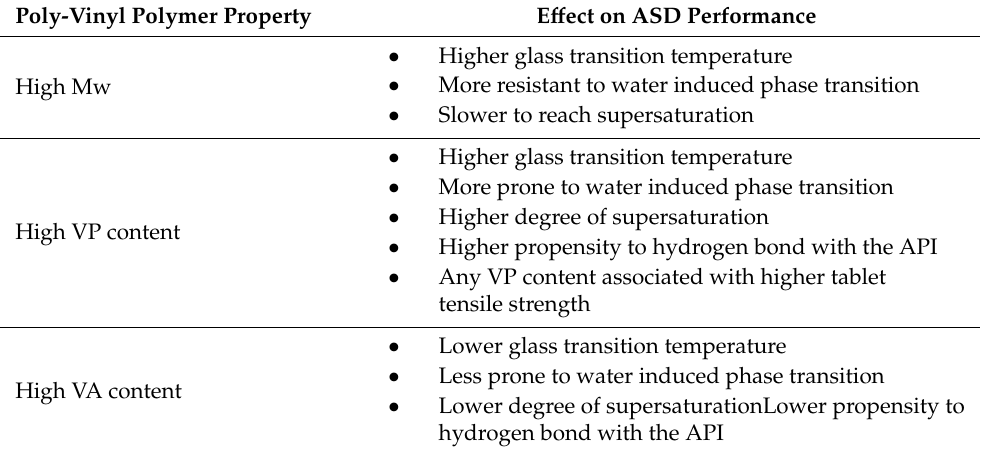
Table 4. Summary of the e ff ects of poly-vinyl polymer properties on polymer–ketoprofen ASD performance.